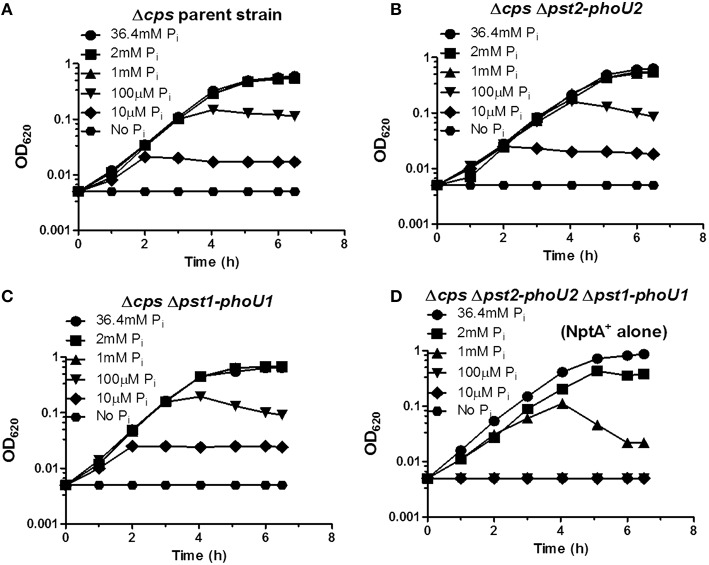
The NptA Na+/Pi co-transporter alone cannot provide sufficient Pi for long-term growth in mCDM containing moderately high (1 mM) and lower Pi concentrations. (A) Representative growth curves of unencapsulated parent strain Δcps (IU1945) in mCDM with 36.4, 2, 1 mM, 100, 10 μM, and no Pi. (B) Representative growth curves of unencapsulated Δcps Δpst2-phoU2 mutant (K583) in mCDM with 36.4, 2, 1 mM, 100, 10 μM, and no Pi. (C) Representative growth curves of unencapsulated Δcps Δpst1-phoU1 mutant (E595) in mCDM with 36.4, 2, 1 mM, 100, 10 μM, and no Pi. (D) Representative growth curves of unencapsulated Δcps Δpst2-phoU2 Δpst1-phoU1 mutant (IU5774), which only contains the NptA Na+/Pi transporter, in mCDM with 36.4, 2, 1 mM, 100, 10 μM, and no Pi. Growth curves were determined at least 3X independently.